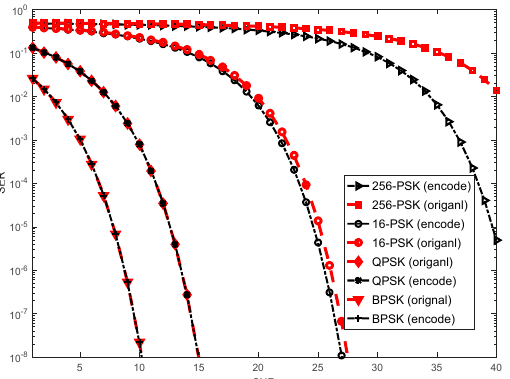
Figure 7. The symbol error rates (SERs) versus signal-to-noise ratio (SNR) for Binary Phase Shift Keying (BPSK), Quadrature Phase Shift Keying (QPSK), 16-Phase Shift Keying (16-PSK) and 256-Phase Shift Keying (256-PSK).